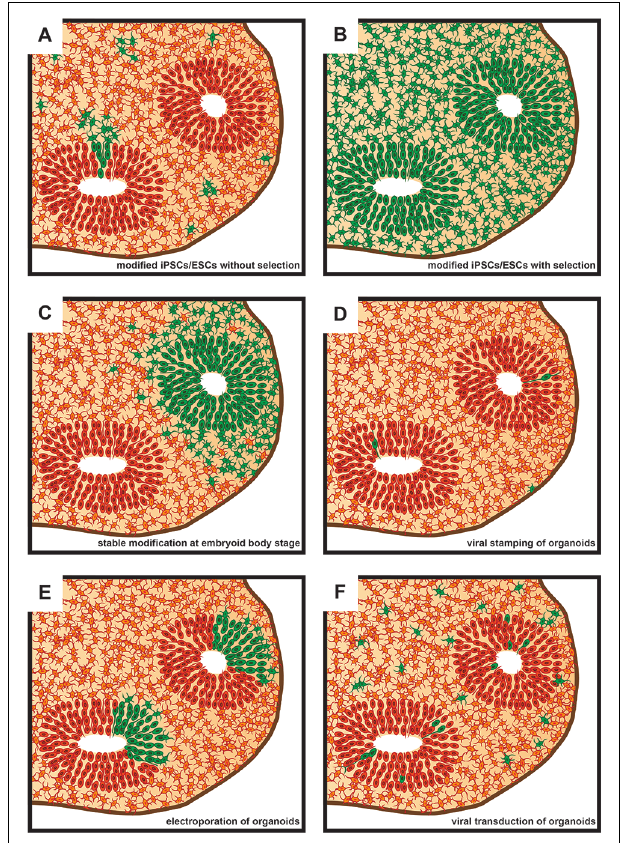
FIGURE 2 | Schematic representation of sections of brain organoids as seen subsequent to various approaches of genetic modification. Green denotes genetically modified cells. (A) Brain organoid derived from genetically modified induced pluripotent stem cells (iPSCs)/embryonic stem cells (ESCs) that did not undergo subsequent positive selection. (B) Brain organoid derived from genetically modified iPSCs/ESCs that underwent subsequent positive selection using FACS or antibiotic resistance. The vast majority of cells within the brain organoid will contain the genetic modification. (C) Brain organoids derived from an embryoid body (EB) that underwent regional genetic modification through the use of an electroporation-based approach. Note that a ventricle-like structure will only show genetic modification if transfection efficiency and cell survival is sufficiently high in the targeted region of the EB. (D) Brain organoid following genetic modifications being targeted to single cells using viral stamping. Cells both at and away from, the brain organoid surface can be targeted. (E) Brain organoid following the electroporation of genetic cargo into ventricle-like structures. (F) Brain organoid following virus-based (e.g., lentivirus or adeno-associated virus, AAV) genetic modification approaches. The proportion of genetically modified cells can vary greatly depending on incubation times of brain organoids in medium containing viral